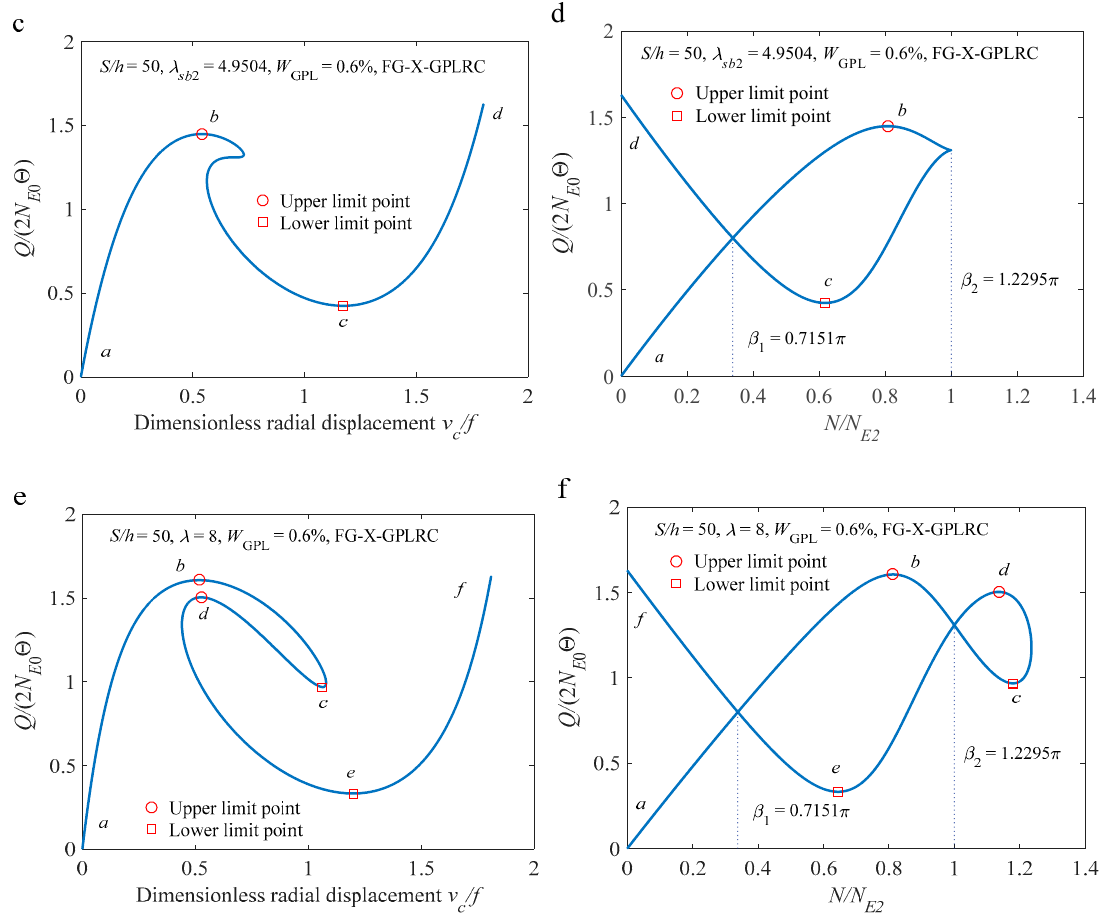
Figure 4. Multiple equilibria of FG-X-GPLRC arch with pinned-fixed end: ( a , b ): λ = 2.1672;